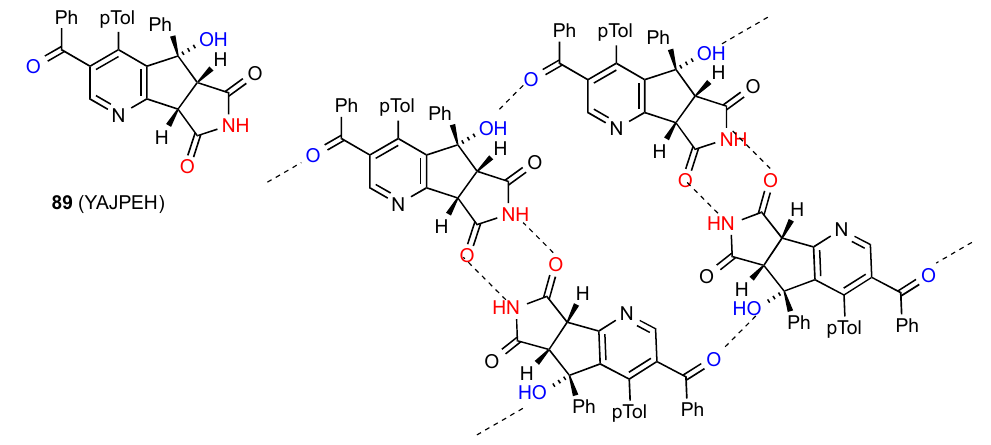
Figure 31. Structure adopted by compound 89.